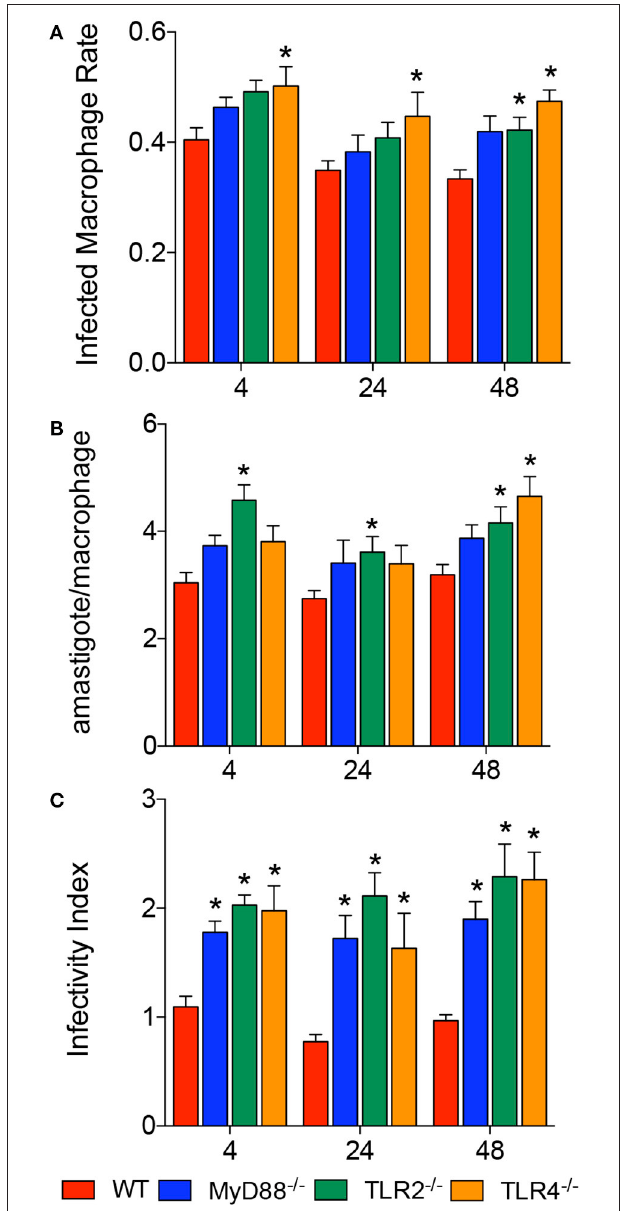
FIGURE 1 | Infectivity of L. amazonensis in macrophages from WT, MyD88 − / − , TLR2 − / − , and TLR4 − / − mice. Results from evaluations of the percentages of infected macrophages (A) , numbers of amastigotes per infected macrophage (B) , and infectivity index (C) in BMDMs from WT (red), MyD88 − / − (blue), TLR2 − / − (green), and TLR4 − / − (orange) mice. Each bar represents the mean ± SEM of the values obtained from three independent experiments ( n = 6–9). Statistical significance was determined using non-parametric two-way ANOVA. * p < 0.05 compared to WT